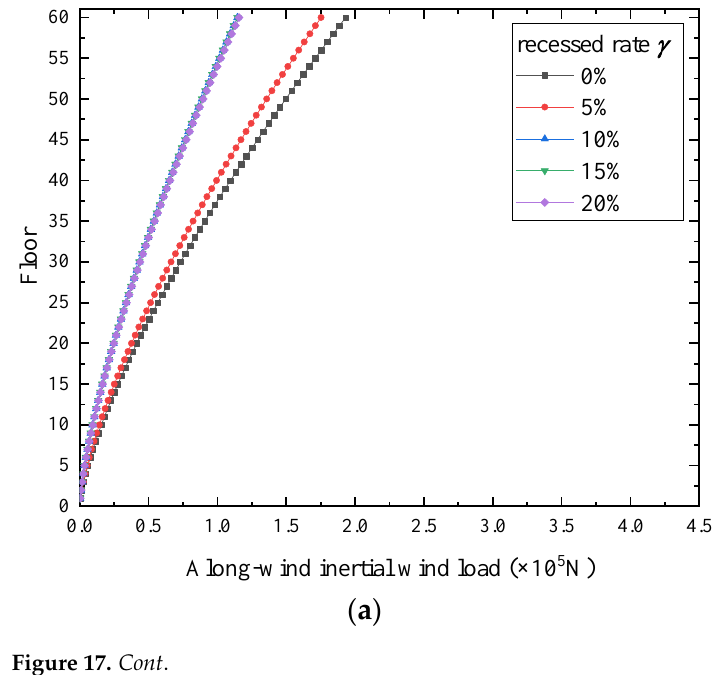
Figure 16. Along − wind mean wind loads. Figure 16. Along-wind mean wind loads. Figure 17 represents the results of the inertial wind loads in along-wind and across- Figure 17 represents the results of the inertial wind loads in along − wind and wind of high-rise buildings. In Figure 17a, the along-wind inertial wind load decreases across − wind of high − rise buildings. In Figure 17a, the along − wind inertial wind load de- by increasing the rate of corner set-back. The variation trend is consistent with the RMS creases by increasing the rate of corner set − back. The variation trend is consistent with the drag force coefficients and RMS base moment coefficients in along-wind. When the rate RMS drag force coefficients and RMS base moment coefficients in along − wind. When the of corner set-back exceeds 5%, the along-wind inertial wind load is basically constant rate of corner set − back exceeds 5%, the along − wind inertial wind load is basically constant with the increase of the corner set-back rate, and the along-wind inertial wind load on with the increase of the corner set − back rate, and the along − wind inertial wind load on the top of high-rise buildings is reduced by approximately 40%. As seen in Figure 17b, the top of high − rise buildings is reduced by approximately 40%. As seen in Figure 17b, inertial wind load in across-wind decreases with increasing of the corner set-back rate. The inertial wind load in across − wind decreases with increasing of the corner set − back rate. across-wind inertial wind load on the top of the building is decreased by about 67% for a The across − wind inertial wind load on the top of the building is decreased by about 67% corner set-back rate of 20%. In addition, the across-wind inertial wind load is greater than for a corner set − back rate of 20%. In addition, the across − wind inertial wind load is greater the along-wind inertial wind load when the corner set-back rate is less than 15%, while the than the along − wind inertial wind load when the corner set − back rate is less than 15%, along-wind inertial wind load is greater than the across-wind inertial wind load when the while the along − wind inertial wind load is greater than the across − wind inertial wind load corner set-back rates are 15% and 20%. when the corner set − back rates are 15% and 20%.